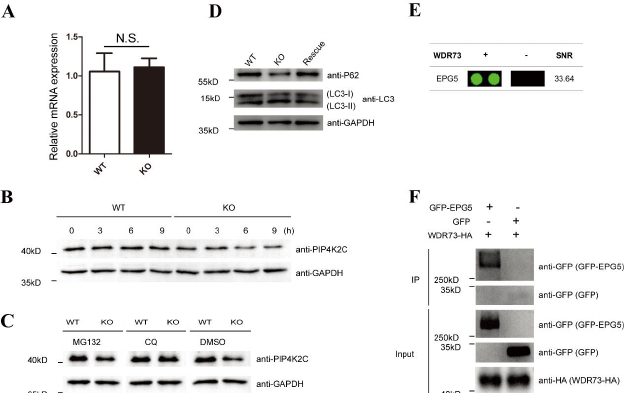
Figure 5. Interaction between WDR73 and EPG5, and autophagy-dependent degradation of PIP4K2C. ( A ) PIP4K2C was not regulated by the WDR73 at the transcriptional level. Total mRNA from WDR73 KO and control cells was extracted and quantitative real-time (qRT–PCR) assays were performed. n = 3. Error bars represent the mean ± SEM. ( B ) The half-life of PIP4K2C decreased in WDR73 KO cells by cycloheximide chase assay. Cells were treated with CHX (100ug/mL) for 0, 3, 6, and 9 h before harvest, followed by Western blot analysis. ( C ) WDR73 KO promoted autophagy–lysosomal degradation of PIP4K2C. Cells were treated with DMSO, MG132 (20 µ M), or chloroquine (50 µ M) for 12 h. ( D ) WDR73 KO enhanced autophagy flux. Western blot analysis of LC3-I/II and p62 levels. ( E ) A direct interaction between WDR73 and EPG5 was shown based on HuProt human protein microarray. ( F ) Co-IP assay showed an interaction between WDR73 and EPG5. N.S.: not